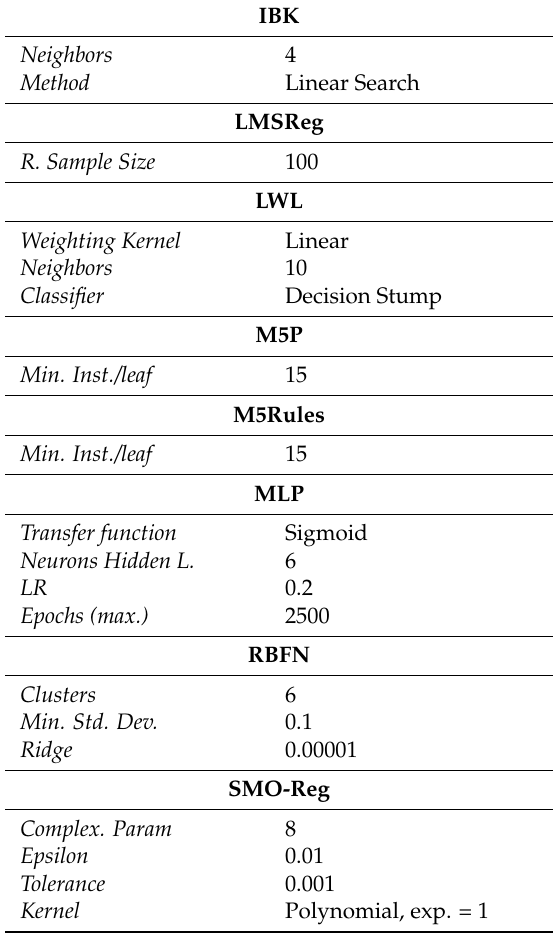
Table 2. Summary of experimental parameters by benchmark